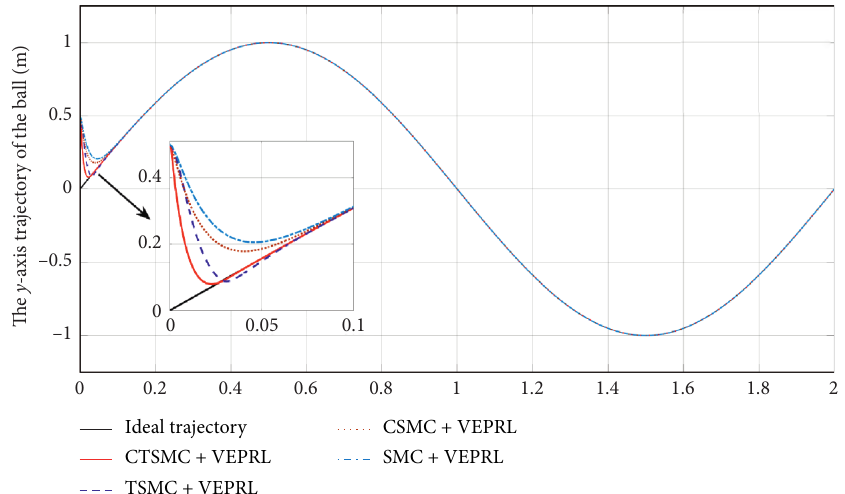
Figure 12: Comparison of y -axis tracking trajectory of the ball and plate system under